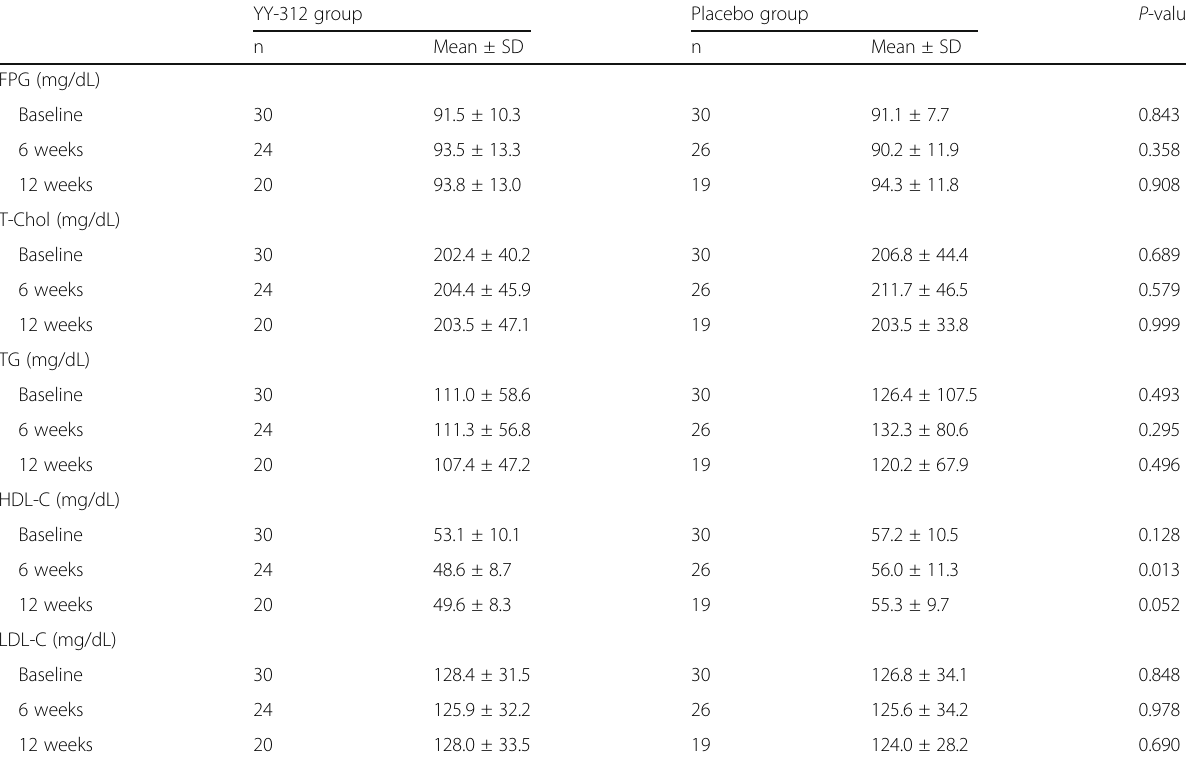
Table 4 Fasting plasma glucose and serum lipid levels by group and visit YY-312 group Placebo group P -value*